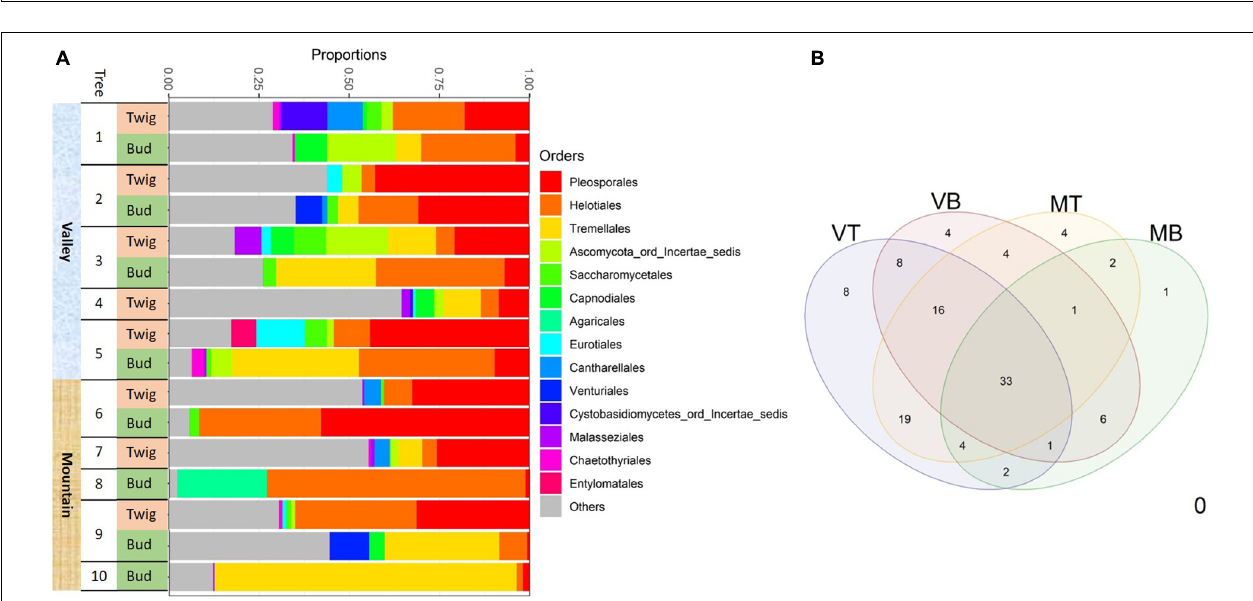
FIGURE 3 | Nonmetric multidimensional scaling (NMDS) of fungal community compositions reveal differences between the organs (A) but not between the sites (B) . The Bray–Curtis dissimilarity matrix was employed. Box and small circles represent samples. Ellipses represent groups (sites and substrates) of fungal communities: ellipses that overlap represent groups of samples with similar species compositions; bud and twig compositions were significantly different from each other, but there were overlaps between the sites. Twig samples were more similar to each other, i.e., more clustered together, than bud samples.